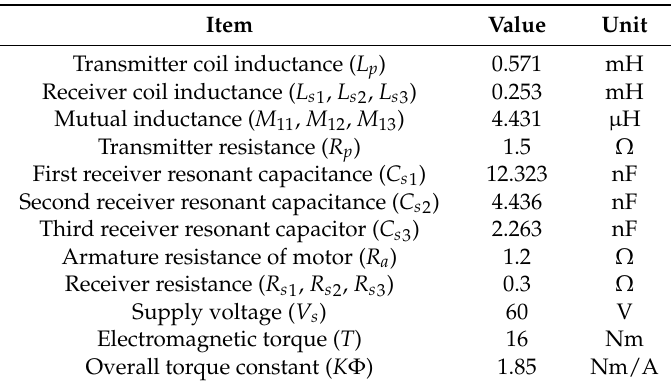
Table 1. Parameters of transmitter and